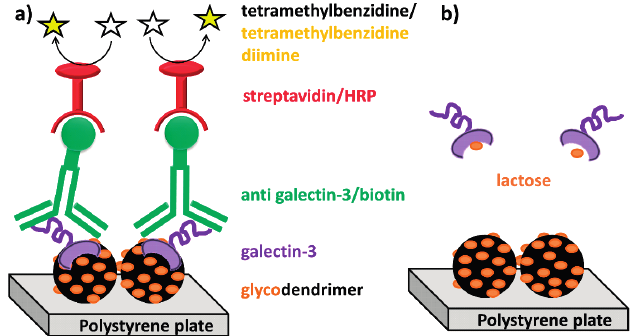
Figure 3. Modified ELISA to study galectin-3 interactions. ( a ) Glycodendrimers were adsorbed to the surface of a plate, and galectin-3 was added to measure binding